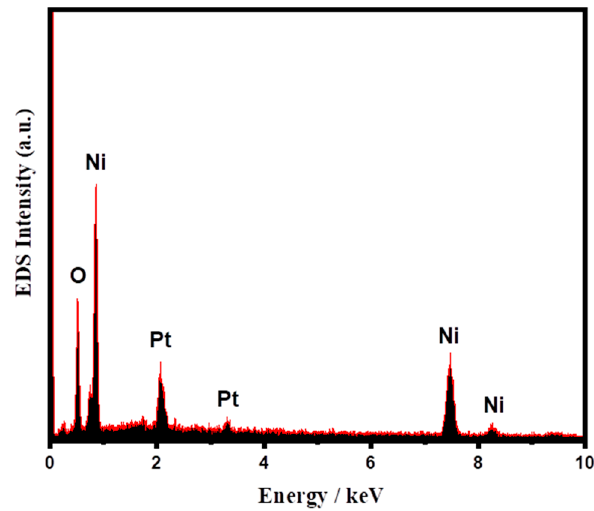
Figure 3. EDS spectrum of NiO.